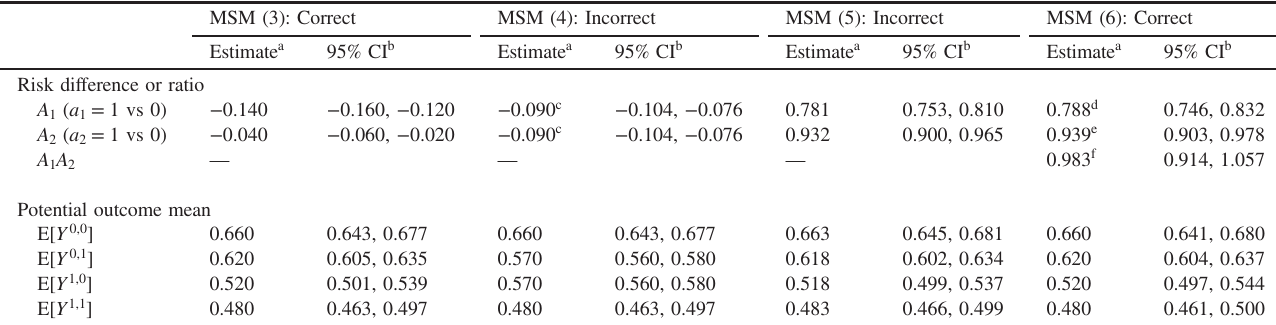
Table 5. Inverse probability weighted estimates of marginal structural models from observed hypothetical cohort data (Table 3) MSM (3): Correct MSM (4): Incorrect MSM (5): Incorrect MSM (6):